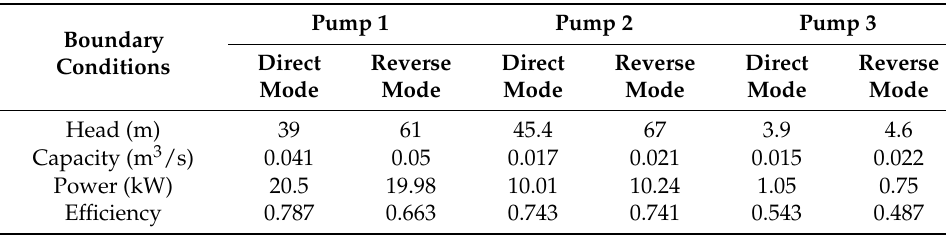
Table 3. Boundary